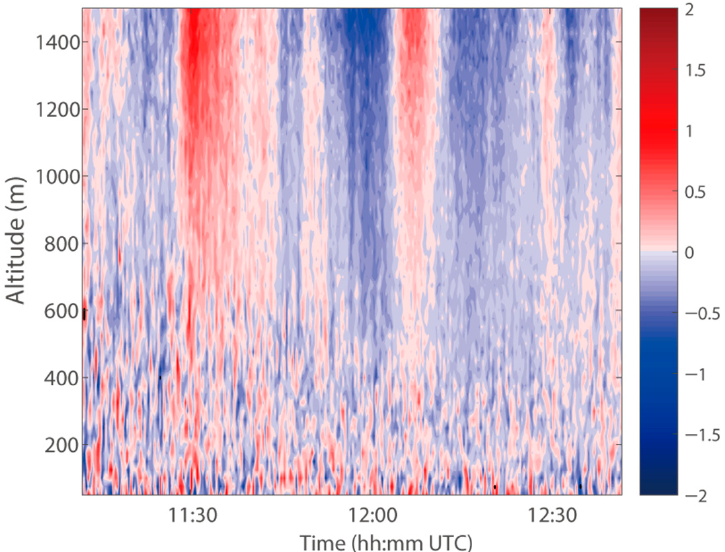
Figure 10. Vertical wind profiles measured using the Windcube 100 s on 2 May 2021. The positive and negative values represent the vertical upward and downward wind speeds (unit: m/s), respectively.